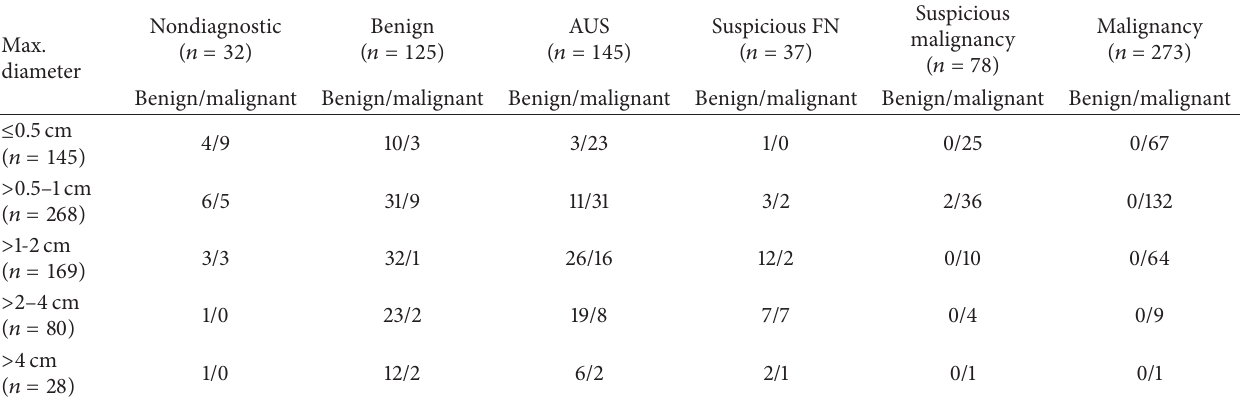
Table 2: Number of benign and malignant thyroid nodules in the different size and Bethesda reporting system categories.